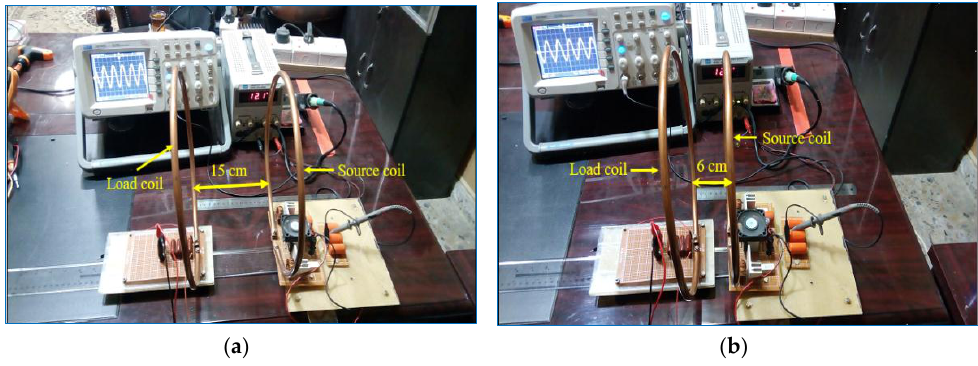
Figure 6. Experiment topology of STLC with a load at ( a ) 6 cm and ( b ) 15 cm.